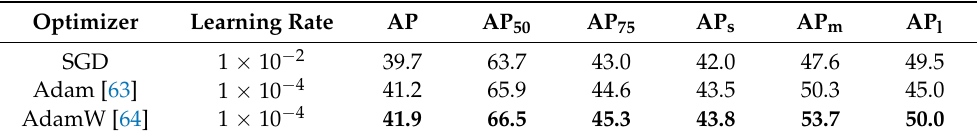
Table 9. Comparing different optimization algorithms on RetinaNet. Since Adam-based optimizers typically require a lower learning rate, we execute Adam and AdamW with a learning rate of 1 × 10 − 4 instead of 1 × 10 − 2 . Adam shows a significant increase in terms of precision compared to SGD and AdamW further increases the precision slightly.